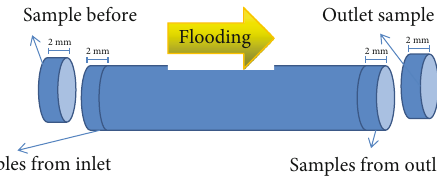
Figure 3: The diagram of core sampling before and after the fl